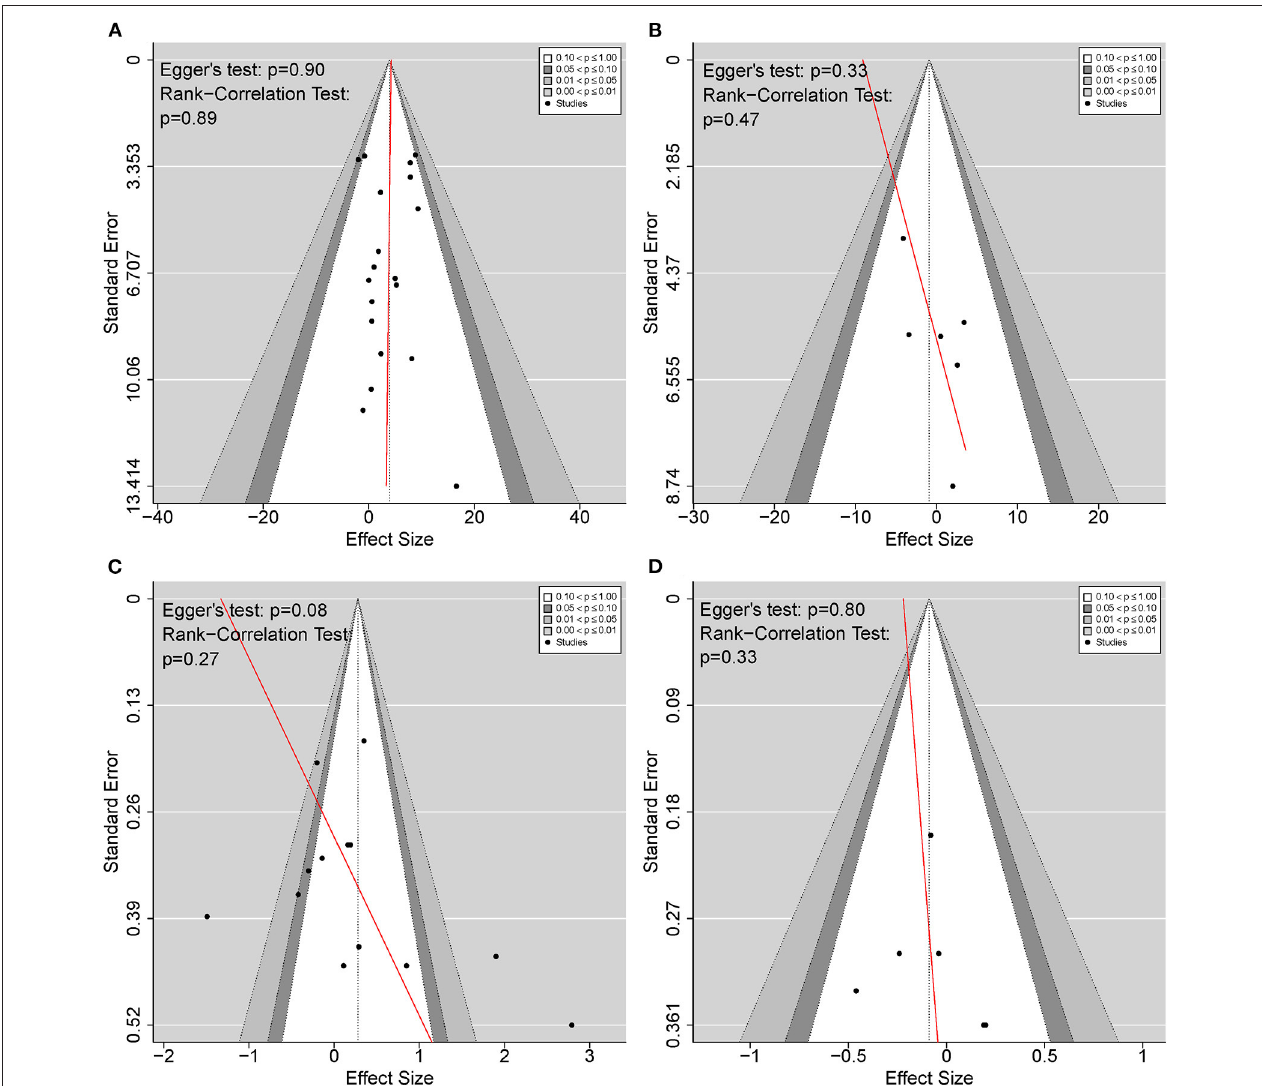
FIGURE 7 | Funnel plots detecting publication bias. (A) BAT vs. CT on the upper extremity motor impairment; (B) BAT vs. UAT on the upper extremity motor impairment; (C) BAT vs. CT on the upper extremity functional performance; (D) BAT vs. UAT on the upper extremity functional performance. BAT, bilateral arm training; CT, conventional therapy; UAT, unilateral arm